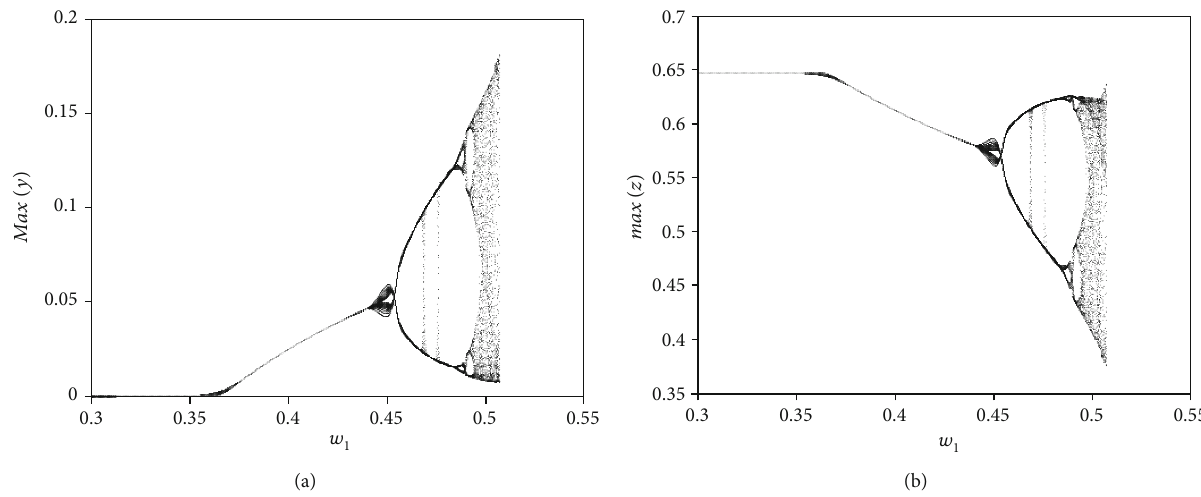
0 : 3, 0 : 55 Þ . (b) The